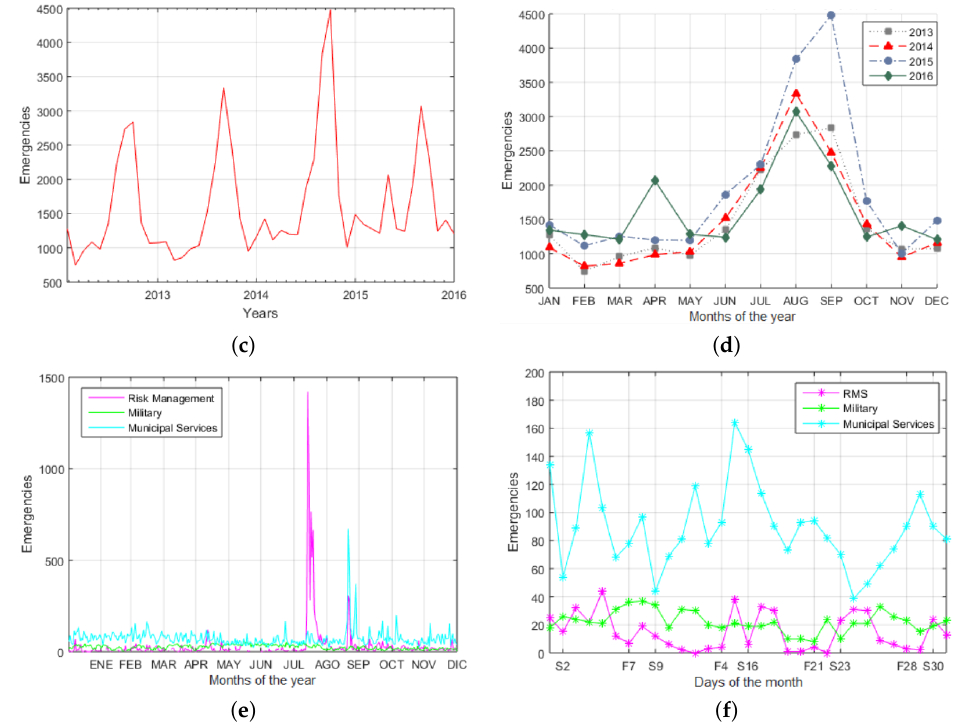
Figure 6. Emergencies registered during 2014, grouped by temporal visual trends: ( a , b ) police, health, and transit services; ( c , d ) fire brigade; ( e , f ) risk management secretary (RMS), military, and municipal